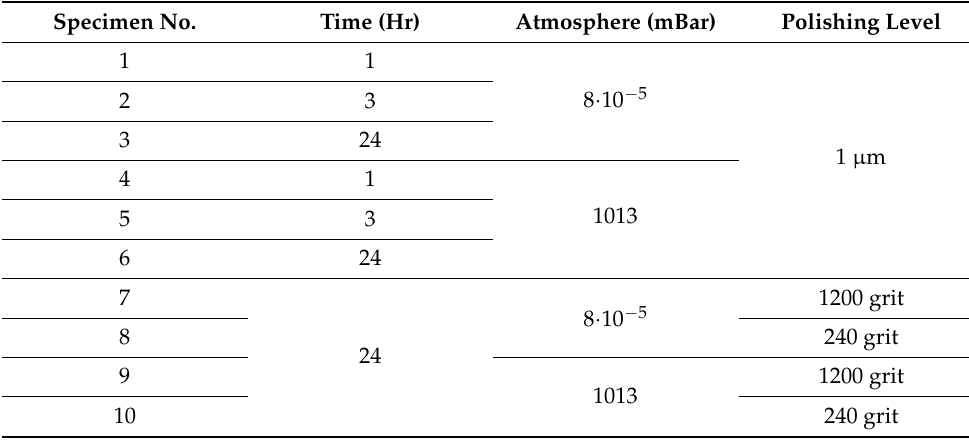
Table 1. Diffusion bonding parameters used to bond AA1050 to AA6061.